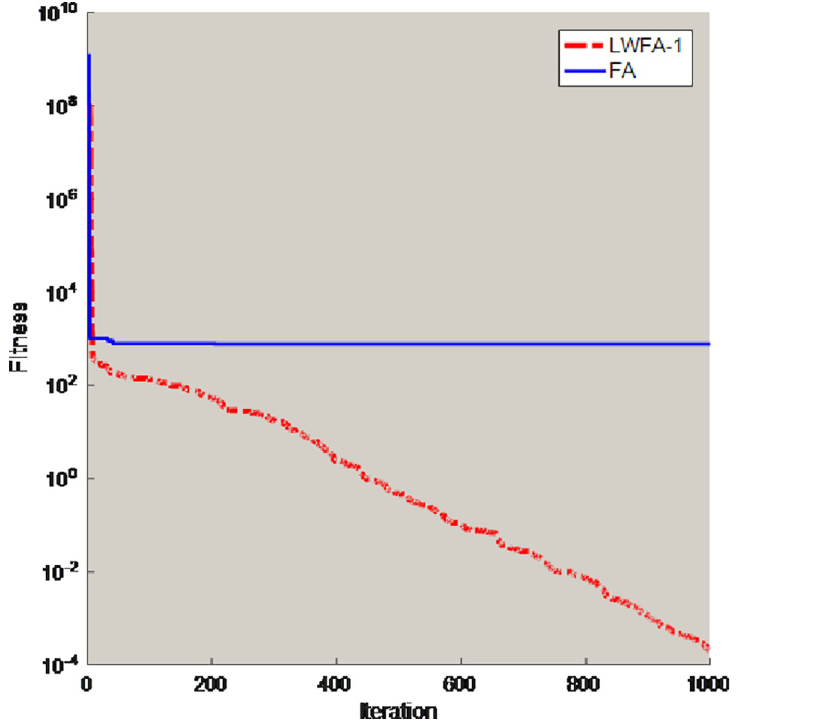
Fig 3. Convergence curves of multimodal functions f 7 .